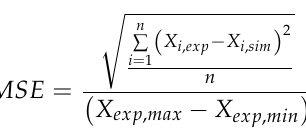
Table 2. RMSE value of water depth and velocity components.